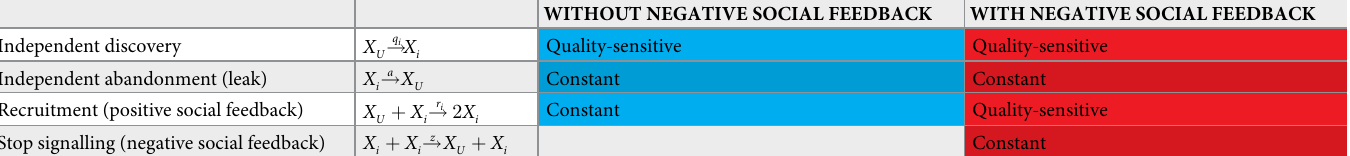
Table 1. The two analysed models can be described in terms of transitions between commitment states by individuals. The commitment states are ‘committed to for- aging patch i ’ ( X i ) or ‘uncommitted’ ( X U ). Both models have the same positive and negative feedback for independent transitions : quality-dependent discovery and constant abandonment (leak a ). The difference lies in the social feedback; one model (blue) has quality-insensitive recruitment ( r other model (red) has both quality-sensitive recruitment ( r i = ρq i ) and quality-insensitive self-inhibition ( z > 0), as reported by field observations [30]. In these representa- tive models, we set rates as constant and (linear) quality-sensitive functions of the quality according to the best function we obtain with numerical optimisation (see S1